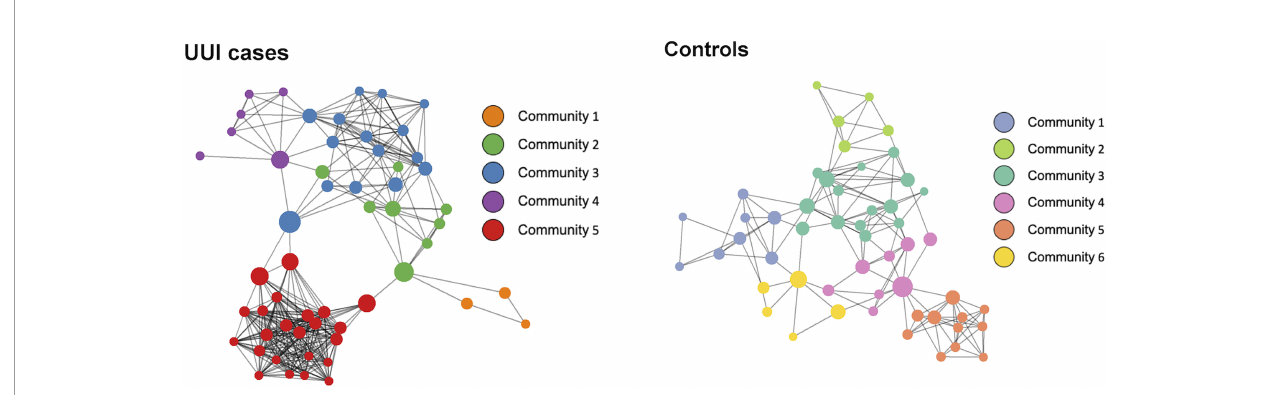
FIGURE 2 | Network visualization of vaginal microbiomes. Each microbiome co-occurrence network, one for the UUI group (left) and one for the control group (right) consists of several bacterial genera (circles, colored by communities of bacteria identi fi ed using the InfoMap algorithm and sized by betweenness centrality value) that are connected to other bacterial genera by co-occurrence (edges/lines connecting circles, identi fi ed by SparCC correlation).